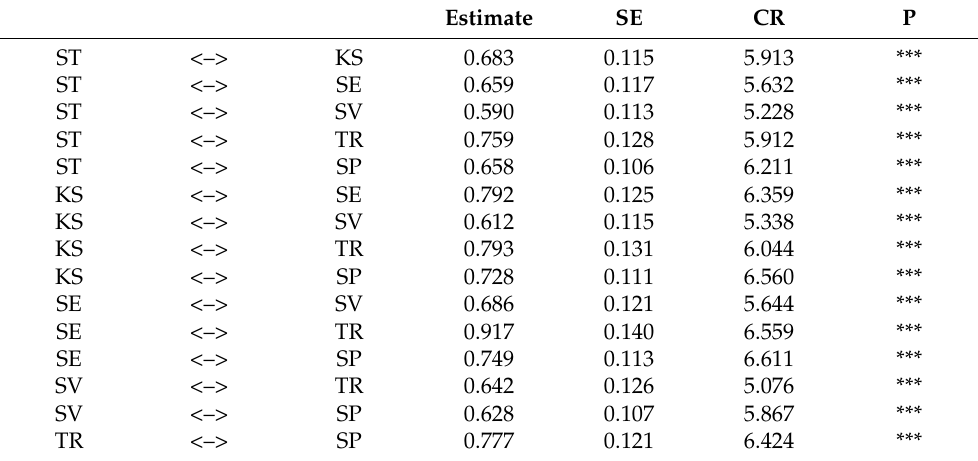
Table 4. Covariance between the latent